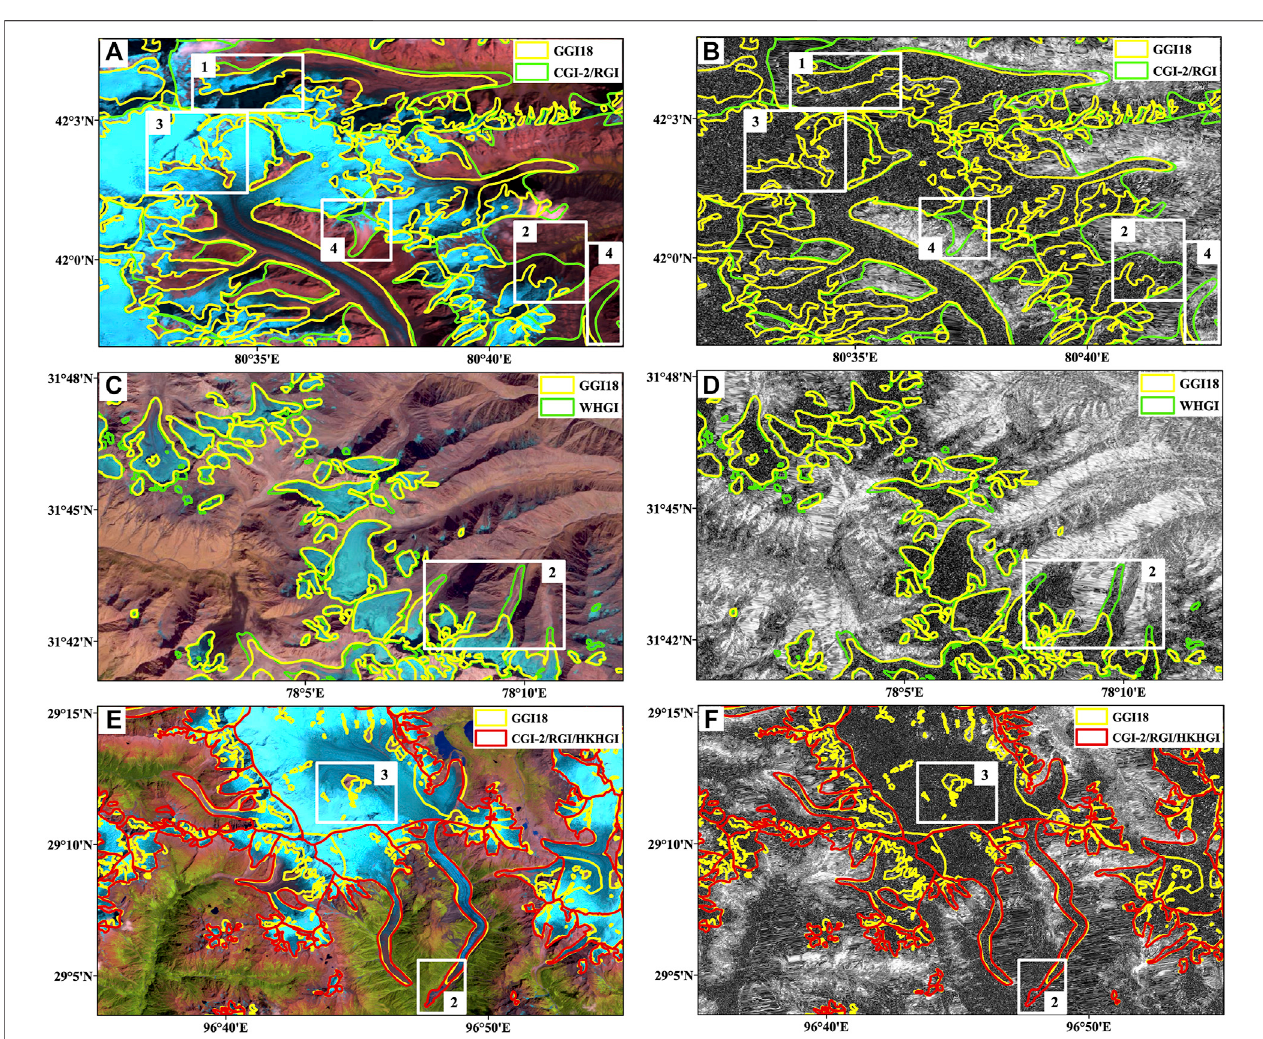
FIGURE 8 | Comparison of glacier outlines between overlapping glacier inventories with the same timestamp. The three row pairs are the small “ snapshots ” of overlapping glacier outlines taken from each of the three areas A, B, C in Figure 1 . Also shown are the false-color (bands 5, 4, 3 as RGB) composite Landsat images taken on (A) 24August 2007, (C) 2August 2002, (E) 8September2005, and the InSAR coherence images created by twoSentinel-1A image pairs takenon (B) 7June 2015and 13July2015, (D) 13July2015and18August 2015,and (F) 25August 2015and18September 2015.Adebris-covered glacierisconsidered tobewell re fl ected bythedark coherenceimage. Thewhiterectangleswithnumbers represent differences inimage interpretation related to(1)steepheadwall,(2)debris-covered glaciers, (3) bare rock or seasonal snow cover, and (4) moraine. Note that the outlines of both the RGI and the HKHGI completely overlap with those of the CGI-2 due